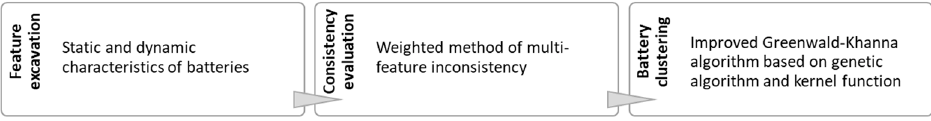
Figure 14. Overview of used battery clustering method proposed in